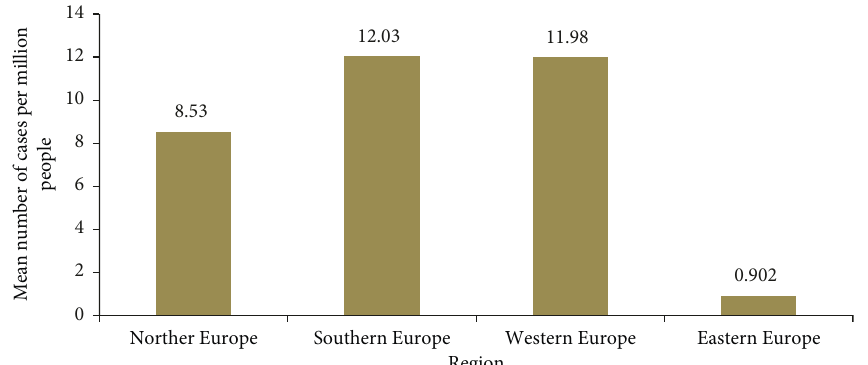
Figure 3: Monkeypox means cases per one million people in the different regions of Europe (cases presented from May 7, 2022, to July 7, Table 2: European regions with the number of countries and mean monkeypox cases per one million people. European